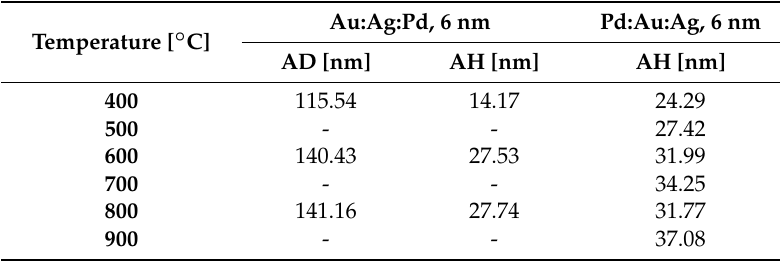
Table A4. Summary of average diameter (AD) and average height (AH) of the samples at distinct annealing temperature and